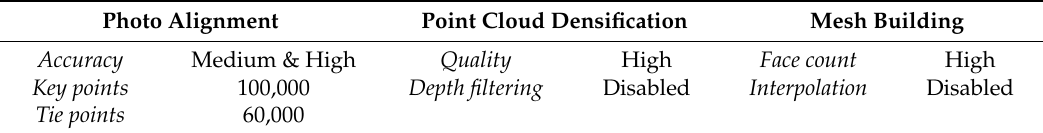
Table 1. Parameter for generation of the PPC with SfM implemented in